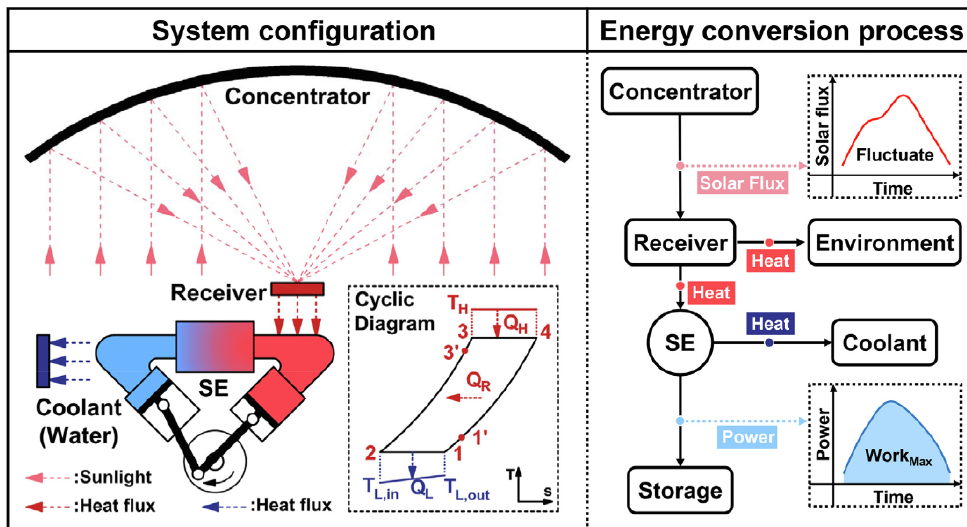
Figure 5. System diagram of solar dish Stirling engine showing its components and the Stirling thermodynamic cycle ( left ); and energy conversion process showing the flow of energy and its conversion in through the system ( right ). (Reprinted from [83] with permission of